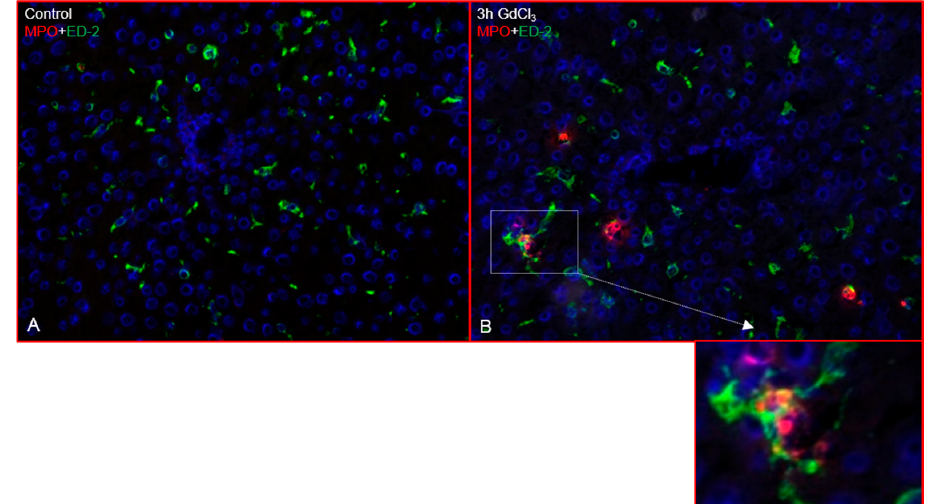
Figure 2. Double immunofluorescence staining of rat liver sections (GdCl 3 treatment) with antibodies directed against ED-2 (green) and MPO (red) followed by fluorescence immunodetection. Liver sections from different time points of study are shown: control ( A ) and 3 h ( B ). Results shown are representative pictures of six animals and six slides per time point. (Original magnification 200×).